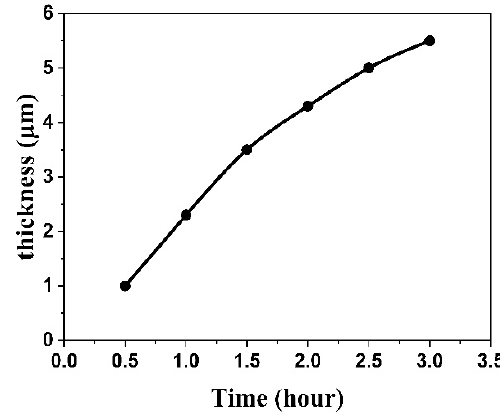
Figure 5. The e ff ects of plating time on the thickness of the electroplated layer. Figure 5. The effects of plating time on the thickness of the electroplated layer.